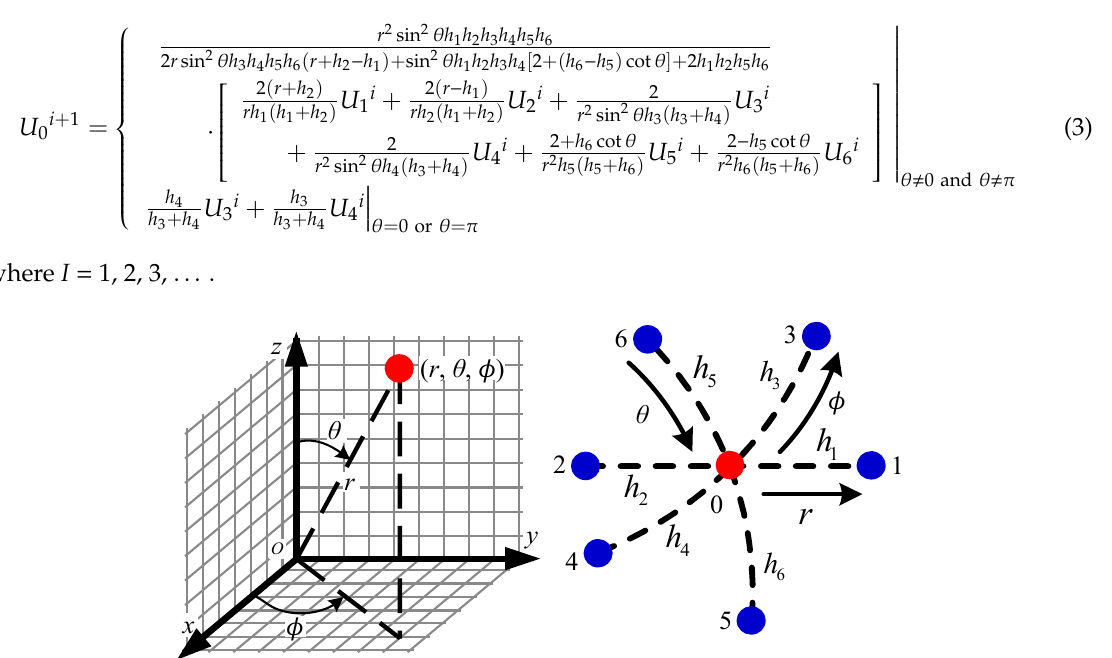
Figure 3. The spatial relationship of 7 points.